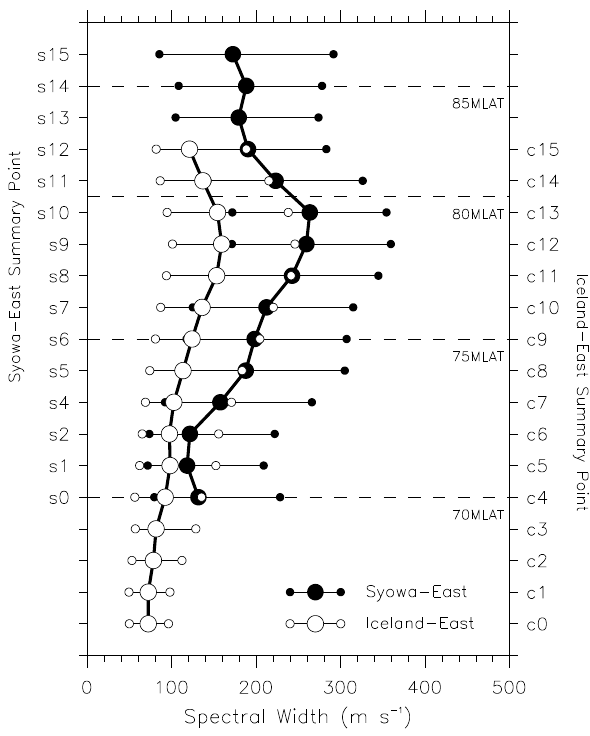
Fig. 8. The median value of the spectral width distribution for Syowa-East and Iceland-East. The results from Syowa-East is dis- played as a line with filled circles, those from Iceland-East being displayed as a line with open circles. Filled small circles indicate the upper quartile and lower quartile,